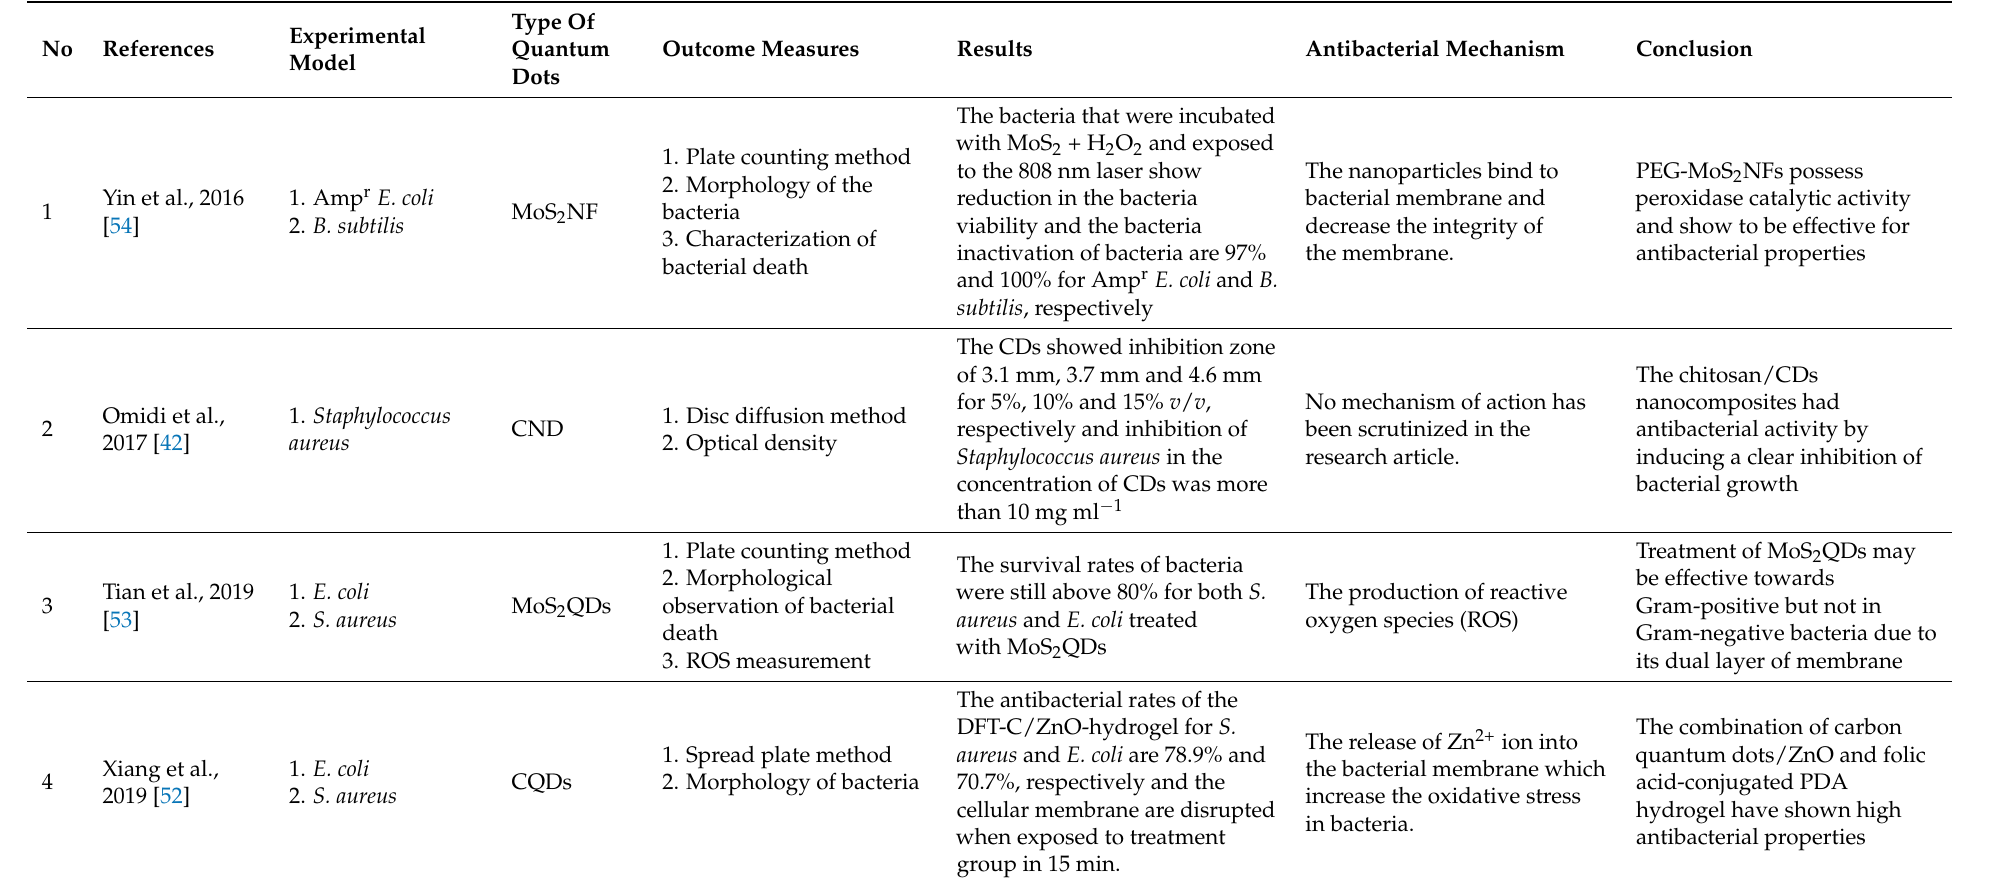
Table 3. Antibacterial properties of quantum